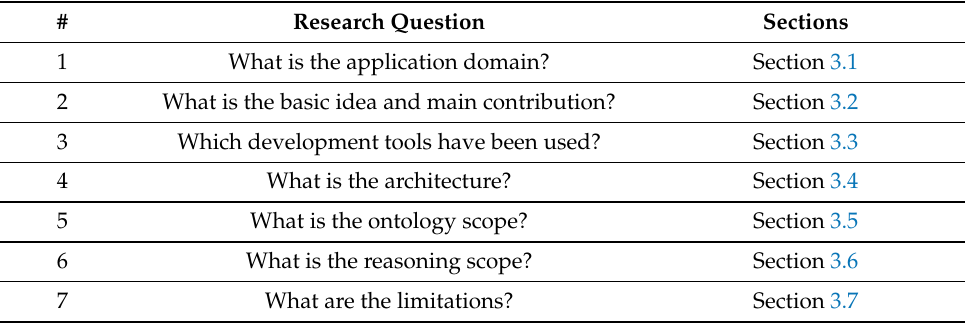
Table 2. KR: evaluation